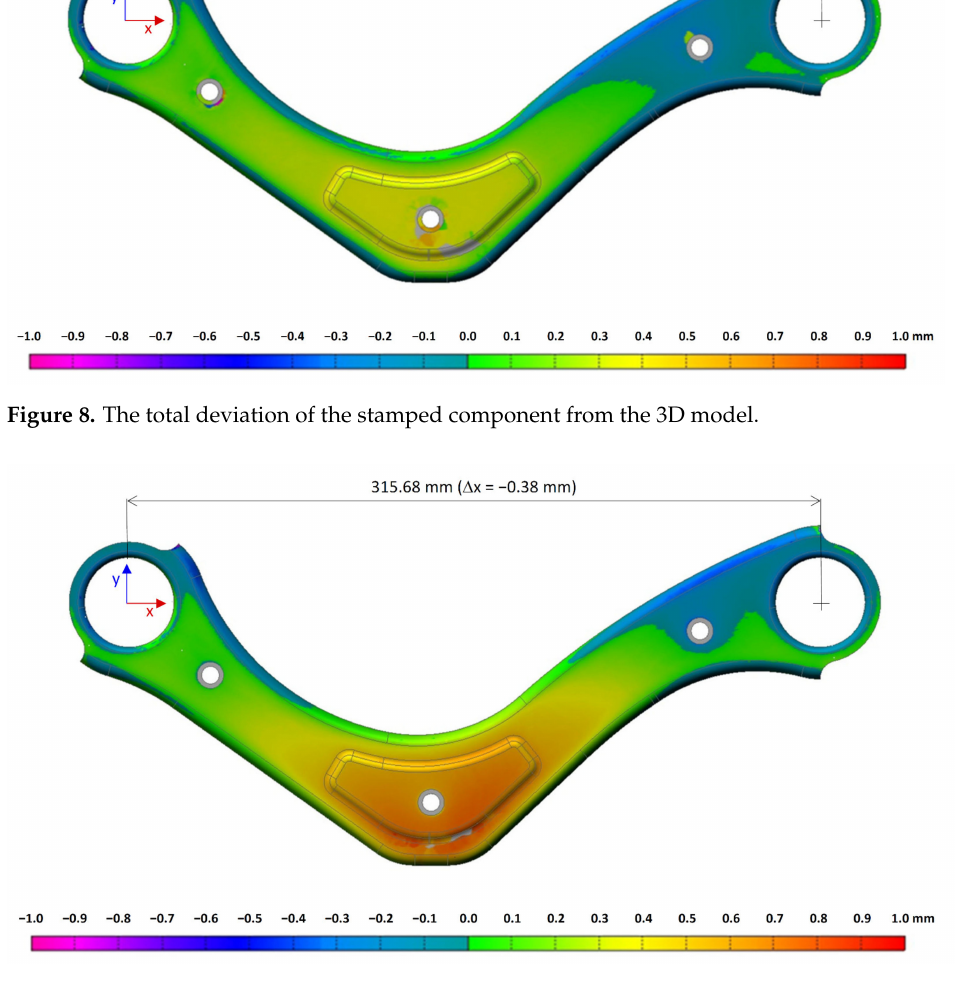
Figure 9. The total deviation of the welded part from the 3D model. Welding parameters ( I = 190 A, v = 60 cm · min − 1 ).